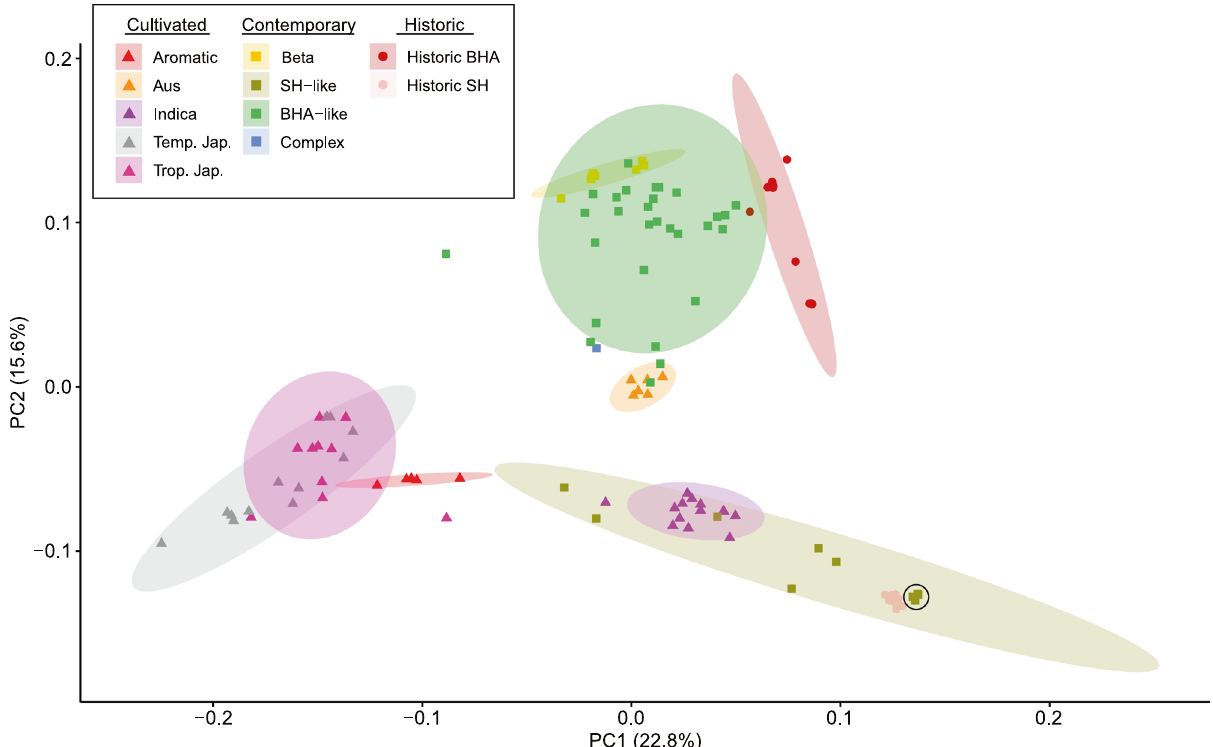
Fig. 1 Principal component analysis (PCA) of genome-wide SNPs in weedy and cultivated rice. PCA of genome-wide SNPs in cultivated ( n = 49), historical weedy ( n = 22), and contemporary weedy rice ( n = 48). The fi rst component seperates the japonica groups on the left and the indica groups on the right. The second component separates SH and SH-like weeds at the bottom from BHA and BHA-like weeds at the top. All hybrid weeds fall between their presumed crop and weed ancestor, consistent with a hybrid origin. Shaded regions represent 95% con fi dence interval of placement of a theoretical new sample. Black circled outline indicates the position of contemporary SH-like weeds that carry herbicide resistance mutations but have no genome-wide evidence of crop-weed hybrid